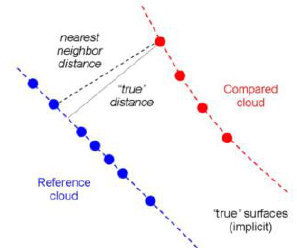
Figure 5. The basic concept of C2C distance computation